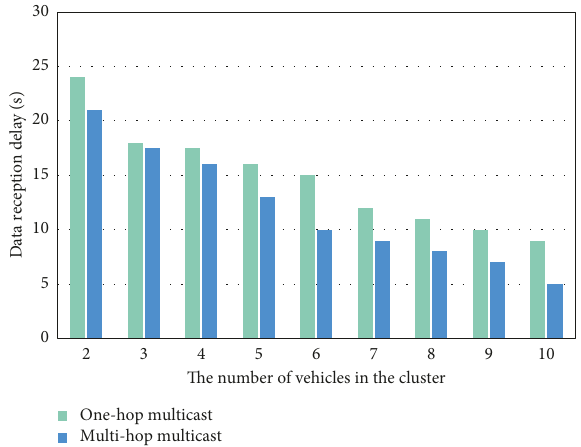
Figure 9: Relationship between data relay rate and the number of vehicles in a cluster based on multihop unicast and one-hop unicast